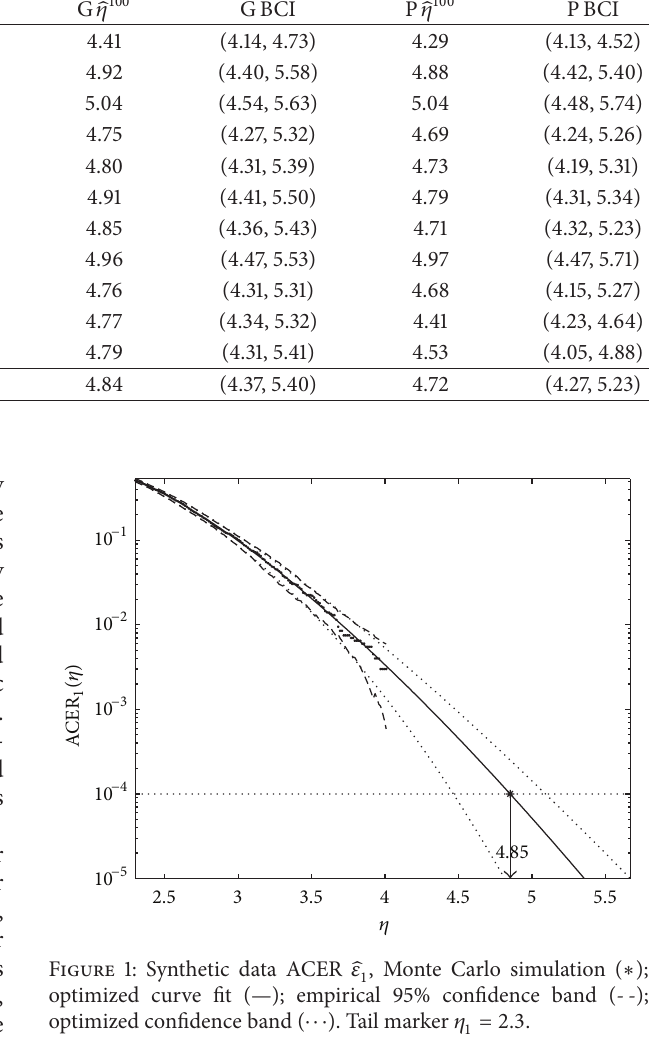
Table 1: 100-year return level estimates and 95% CI (BCI = CI by bootstrap) for A = ACER, G = Gumbel, and P = POT. Exact value = 4.80. Sim. No.